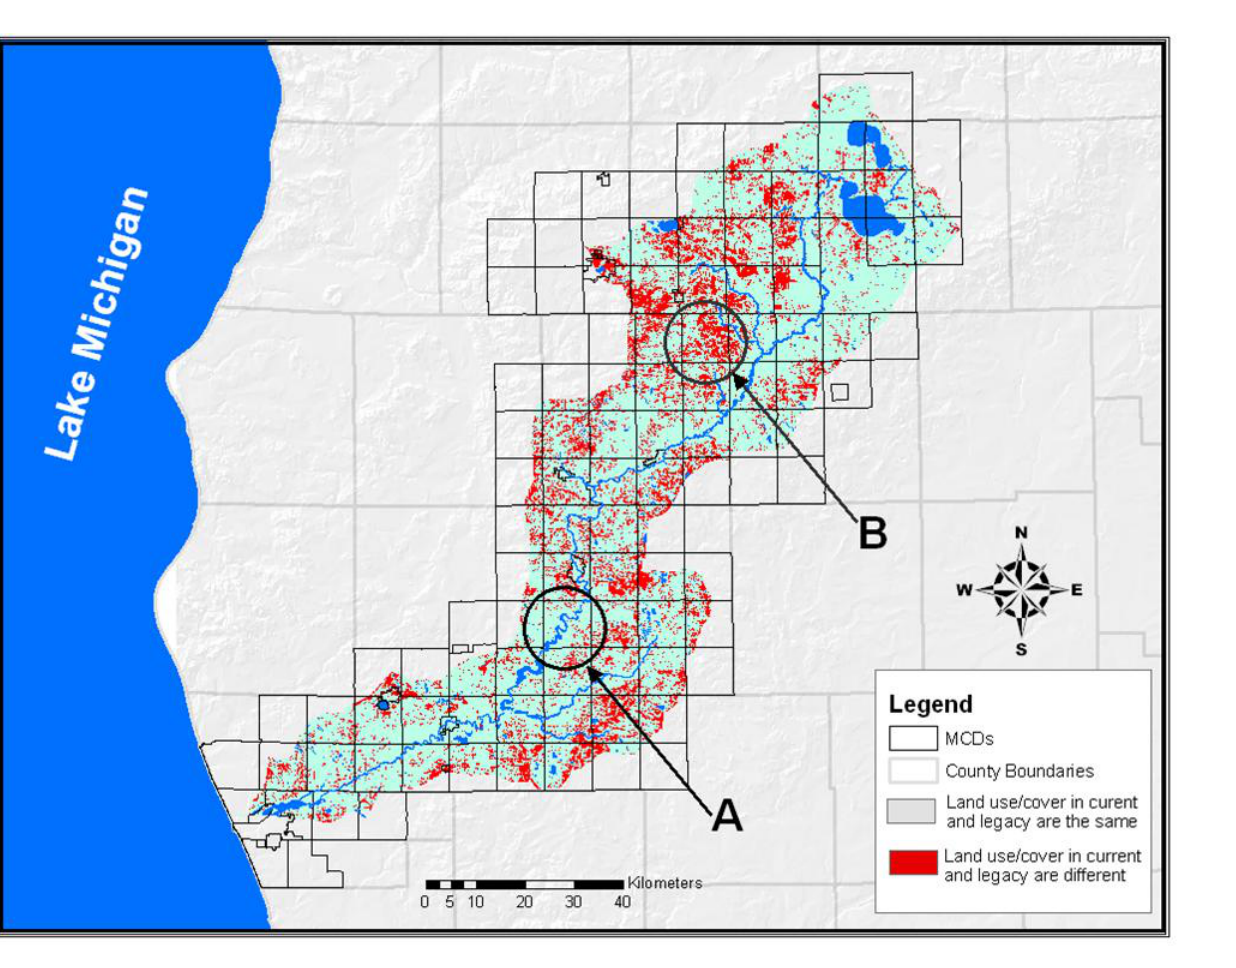
Fig. 8 . Spatial distribution of similarity and dissimilarity of current and legacy land-use/cover maps. See text for areas A and